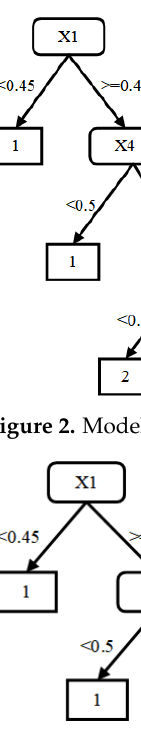
Figure 2. Model 1.